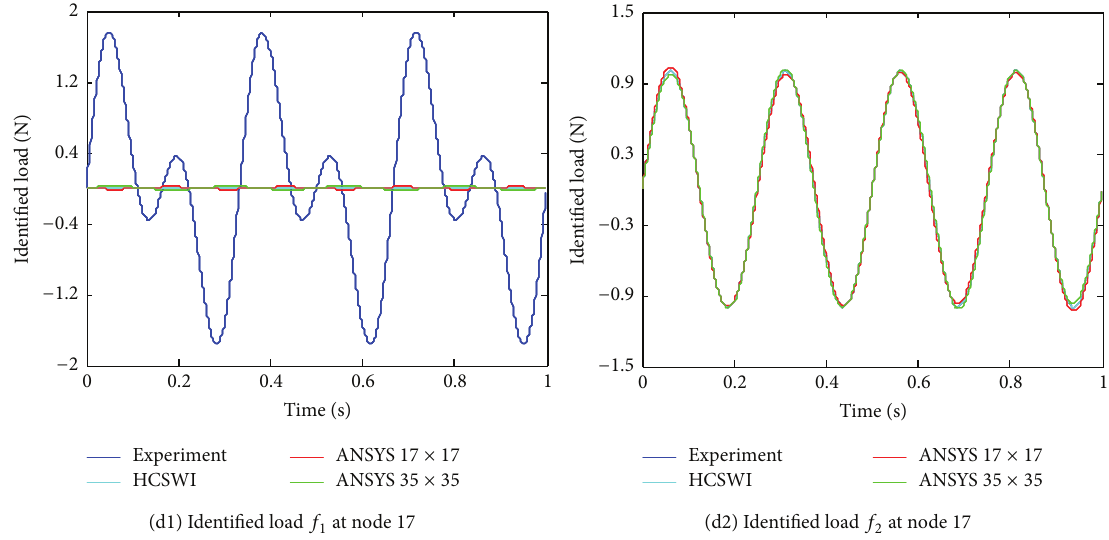
Figure 17: Load identification at different nodes with excitation 𝑓 1 and excitation 𝑓 2 applied at nodes 1 and